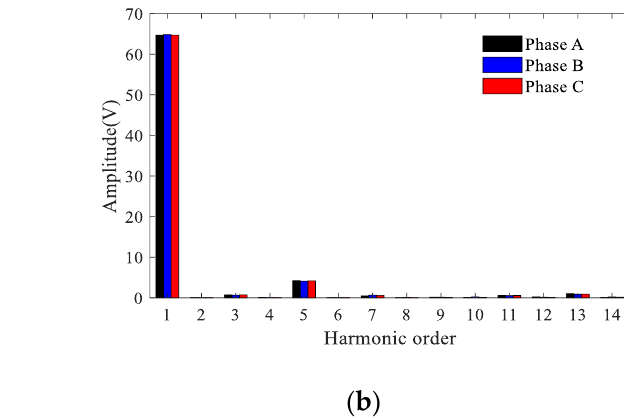
Figure 7. Open-circuit phase back EMF characteristic of the proposed AF-FMPM machine (NS). ( a ) Waveform; ( b ) harmonic spectra.